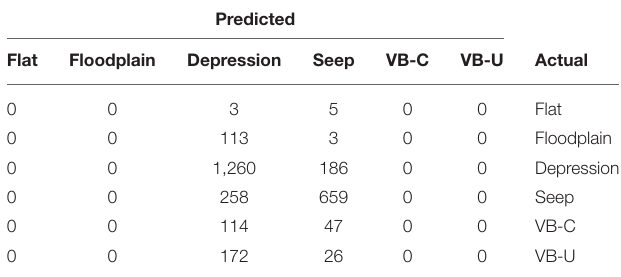
TABLE 5 | Predicted vs. actual assignment of wetland HGM types based on test cases.